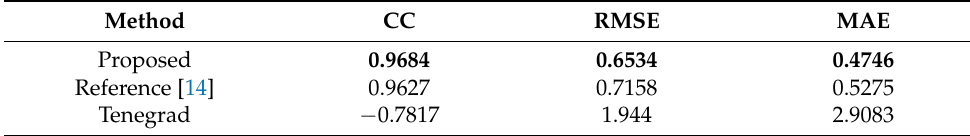
Table 2. Performance of the three evaluation